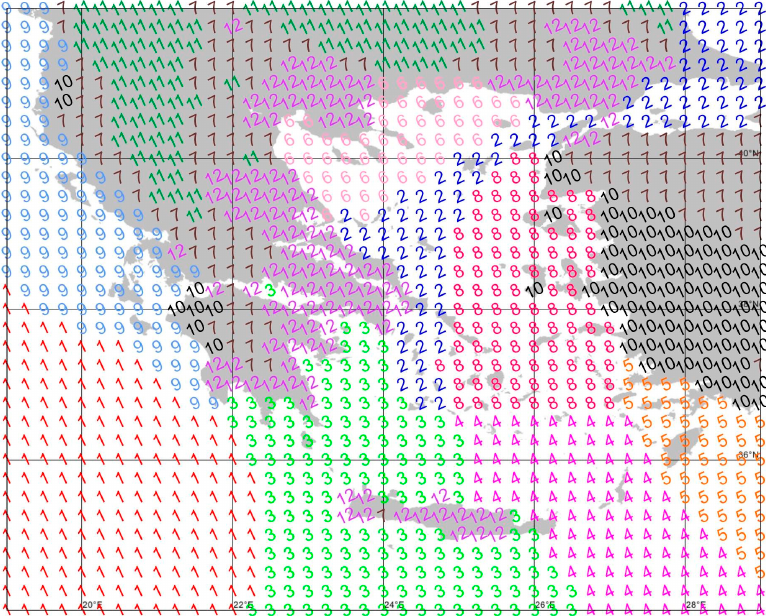
Figure 3. The spatial distribution of the 12 clusters.